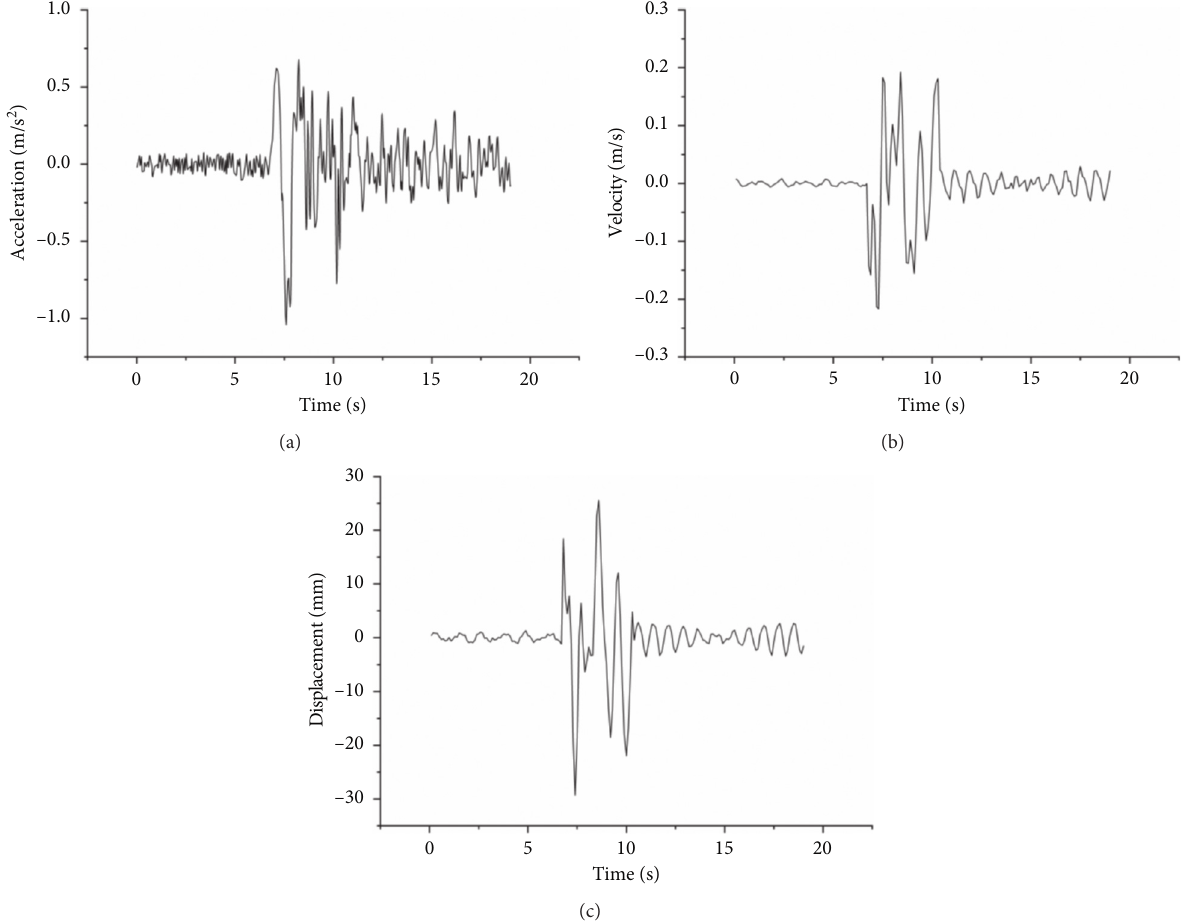
Figure 9: Time history of the Tianjin wave. (a) Lateral acceleration-time curve. (b) Lateral velocity-time curve. (c) Lateral displacement-time